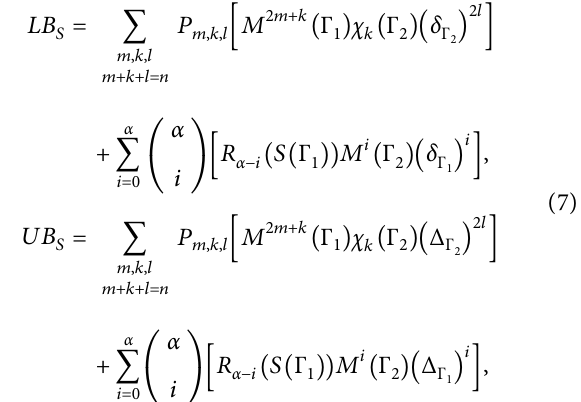
and P along with their F -sum graphs. 5 6